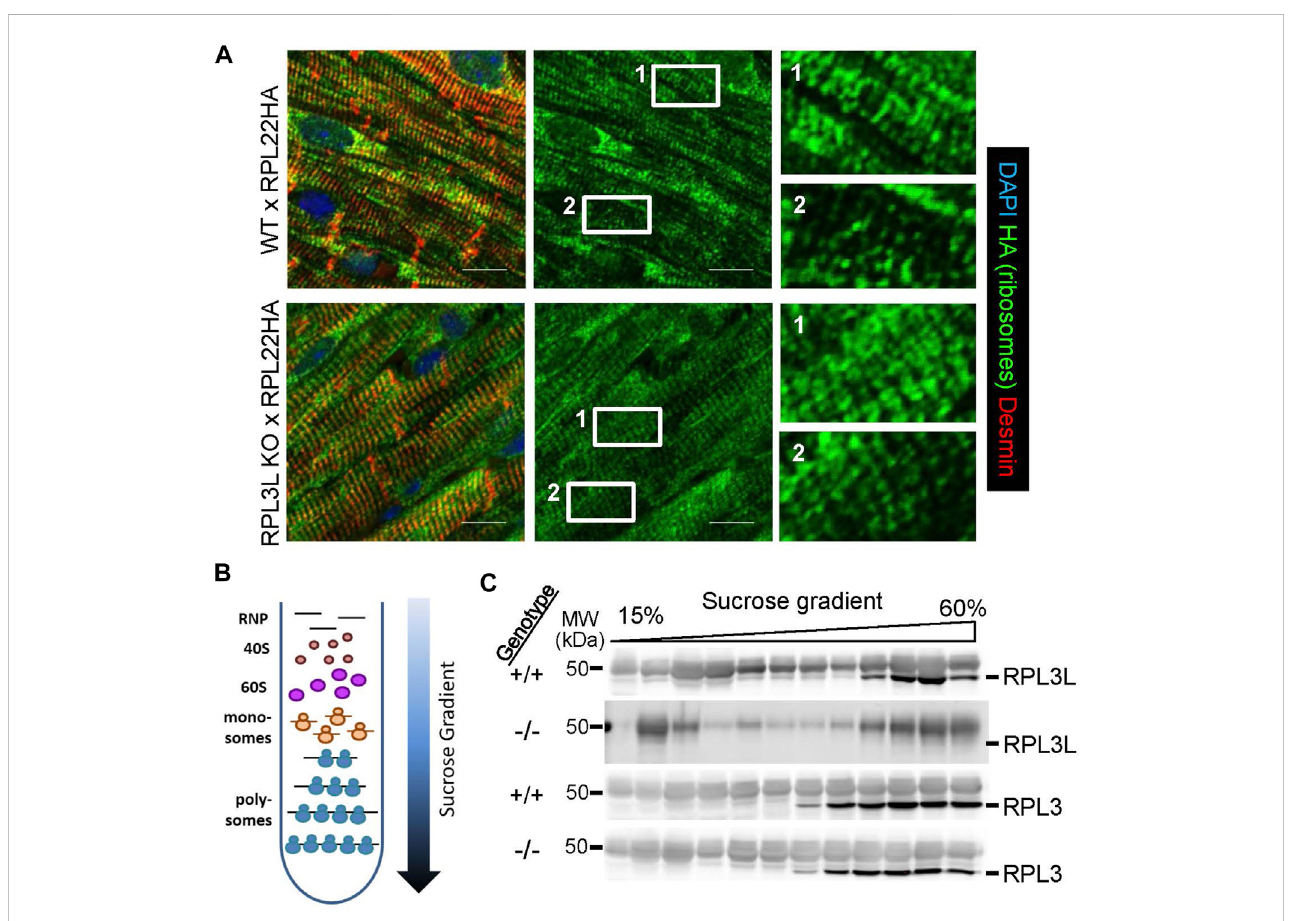
FIGURE 6 Ribosome localization and polysome fractionation between the genotypes. (A) Immunostaining for HA-tagged RPL22 in histological sections from hearts of RiboTag (RPL22-HA) mice crossed with wild type and Rpl3l − / − mice at 2 months of age. The left panels are amerge of HA tag (green) counterstained with desmin (red) and DAPI (blue) to show nuclei, while the center panels show only the HA tag staining (green). The right panels are ×6 magni fi cations of the noted areas (1 & 2) in the HA stain (green) seen in the middle panels (scale bars = 5 µm). (B) Schematic of the sucrose gradients used to fractionate ribosomes into different subpopulations for ribosome pro fi ling analysis of mRNA and western blot analysis of ribosome subunits. (C) Western blots of individualfractionsfromthesucrosegradientsshowingRPL3andRPL3Lexpressionacrosstheribosomalpopulationsin Rpl3l − / − ( − / − )orwildtype(+/+)hearts. MW denotes molecular weight in kilodaltons